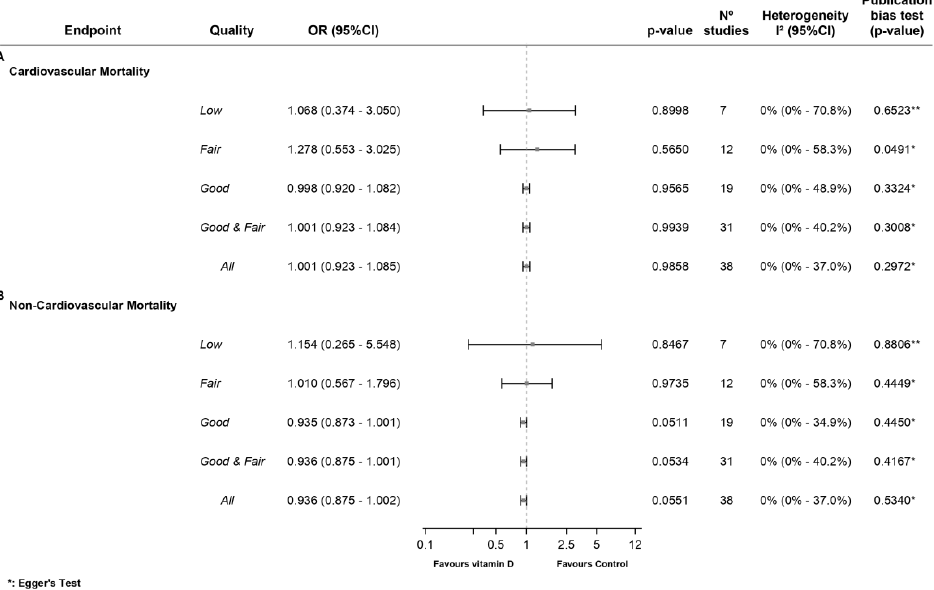
Figure 2. Forest plot of the effect of vitamin D supplementation on all-cause mortality.